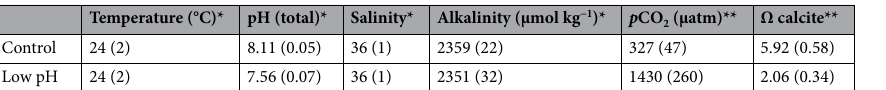
Table 1. Summary of seawater chemistry parameters measured (*) and calculated (**) for the ocean acidification experiment, represented as the mean and standard deviation (between brackets) of measurements taken daily (for 5 days) for the three experimental